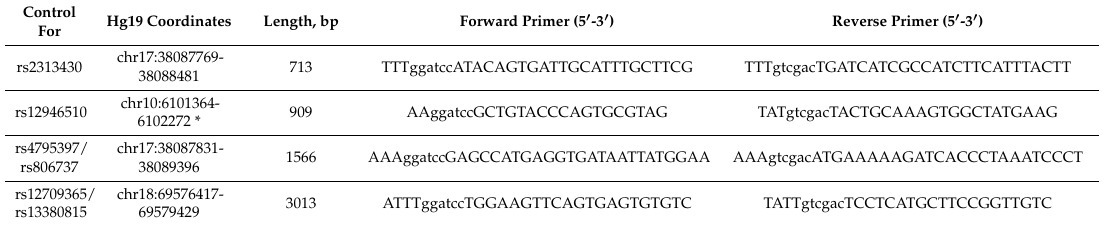
Table 2. Primers used for the cloning of the size-matched control sequences.